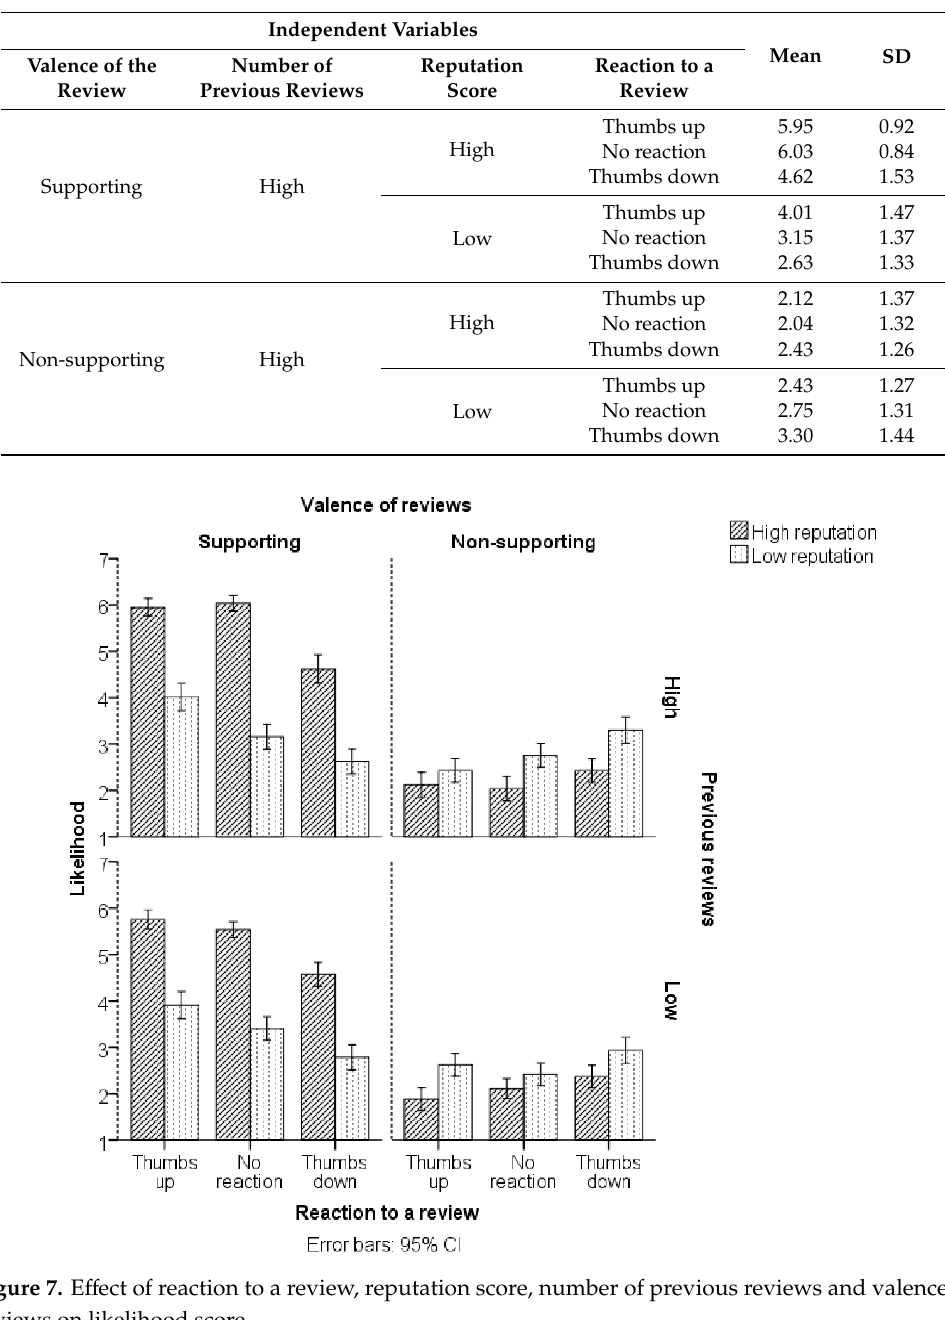
Table 3. Mean values of the likelihood scores.